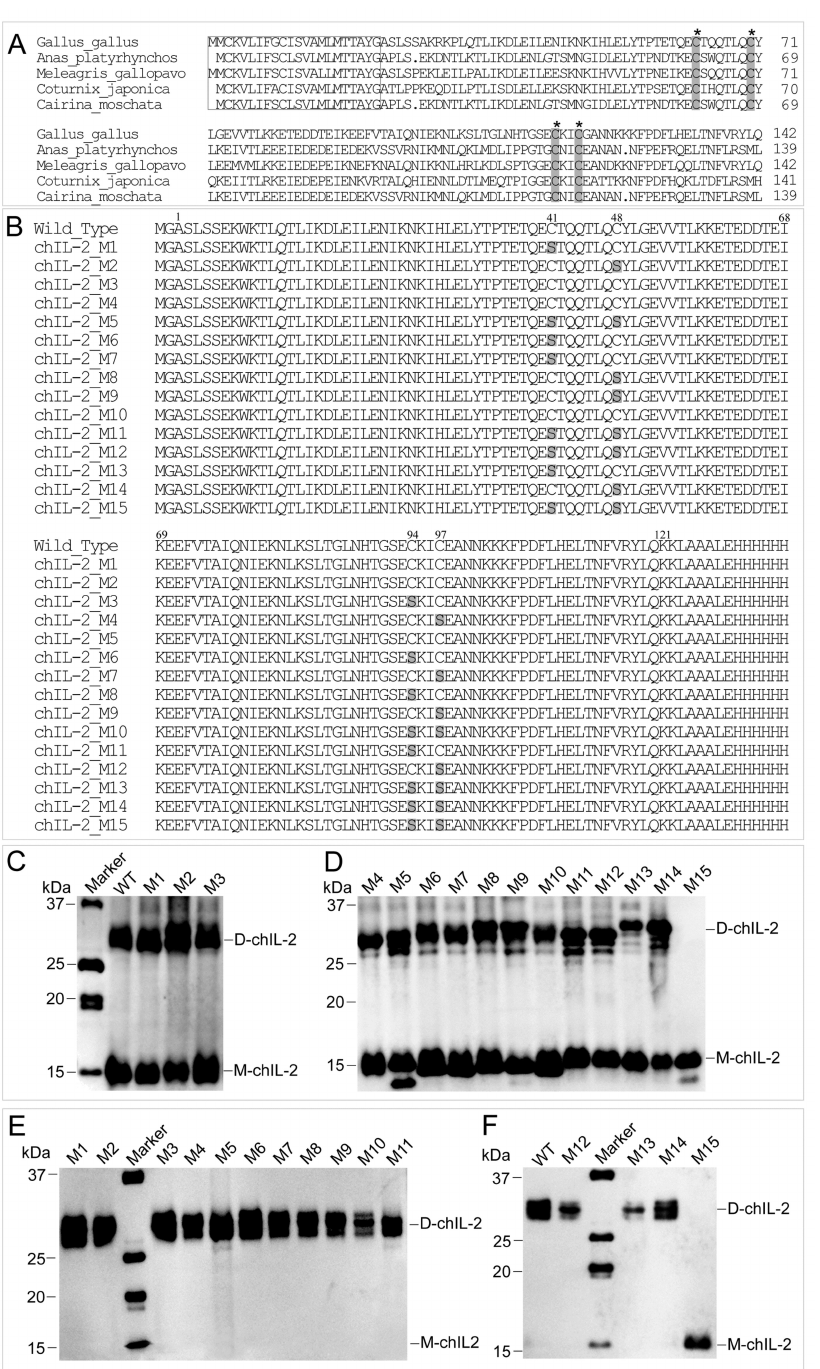
Figure 5. Determination of cysteine sites involved in dimerization. ( A ), the alignment of avian IL-2 precursors. The sequences in rectangles are the signal peptide sequences, while other sequences are that of the mature IL-2. The residues highlighted in grey and indicated by an asterisk (*) are the conserved Cys residues. Dot indicates no amino acid. ( B ), the alignment of chIL-2 wild type and mutants. The numbers on the top of sequence indicate the residue position of mature chIL-2 protein from Ala 1 to Lys 121 . Other residues were generated from expression vector during chIL-2 expression. The residues highlighted in grey are Ser residues mutated from Cys. ( C ) and ( D ), western blotting of chIL-2 purified from E. coli . ( E ) and ( F ), chIL-2 purified from Sf9. M1~M15, chIL-2 mutants with di ff erent Cys mutation combinations (refer to Figure 5B and Table 1). Marker, protein standard marker. WT, wild type